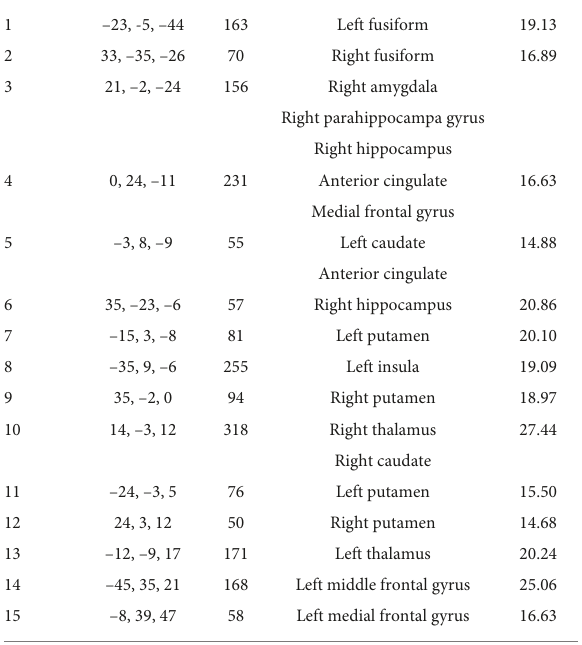
TABLE 2 Brain regions exhibiting higher coefficient of variation (CV) in schizophrenia ( p < 0.05, FDR corrected). Clusters Peak MNI Voxels